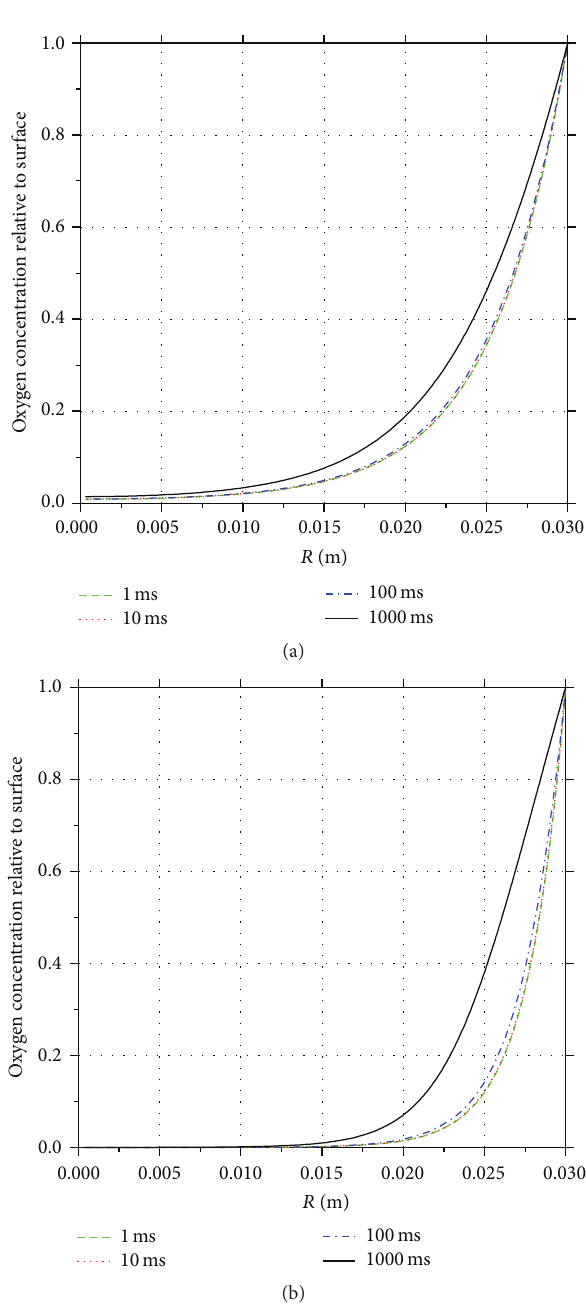
Figure 8: Transient profile of oxygen concentration relative to the graphite surface of